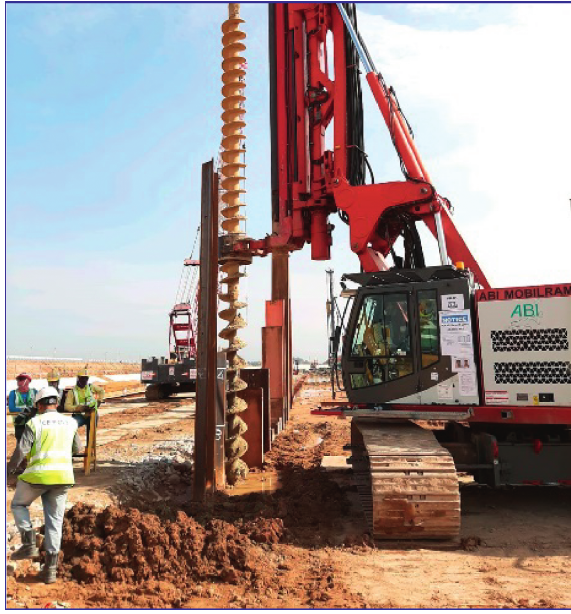
Figure 4: Pre-auguring process to loosen soil for retaining wall installation.